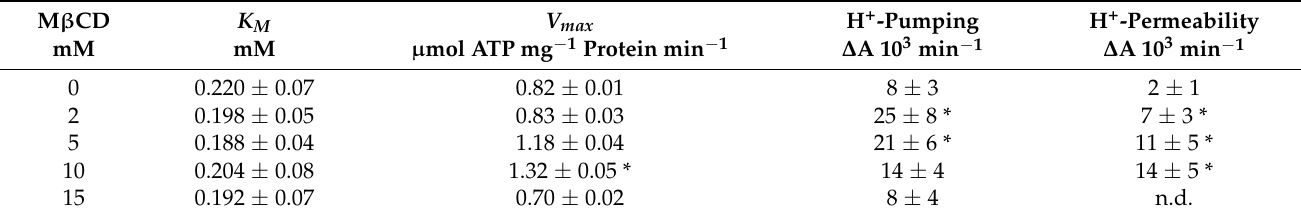
Table 1. Effects of different M β CD concentrations on kinetics parameters of ATP hydrolysis, rates of ATP-dependent H + -pumping, and passive H + -permeability of plasma membrane vesicles. Measurements were carried out in a medium supplemented with 50 mM KCl. Data (mean ± SD) from three independent membrane isolations are presented. * Indicates significant ( p < 0.05) differences with control